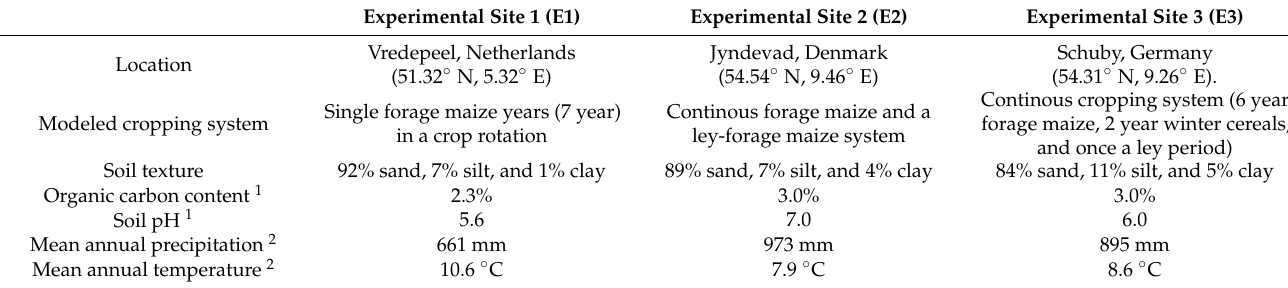
Table 1. Characteristics of the three experimental